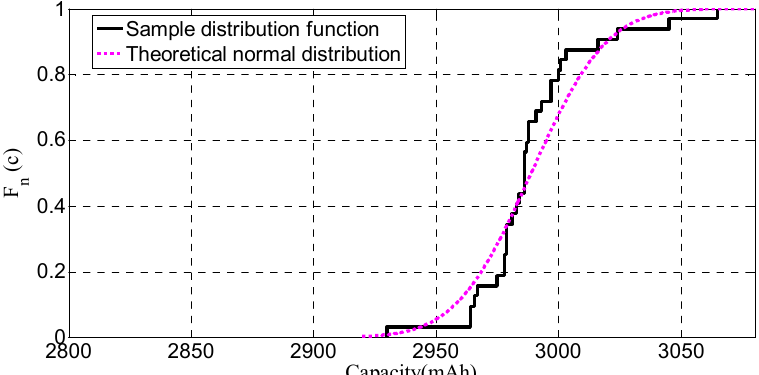
Figure 7. The distribution function and theoretical normal distribution function of the capacity samples before vibration.